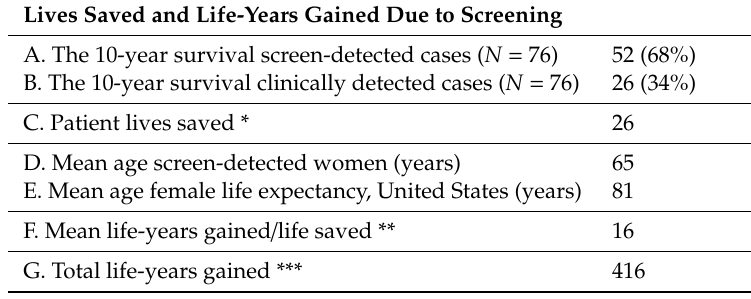
Table 3. Patient lives saved and total life-years gained due to implementation of the Kentucky screening program.